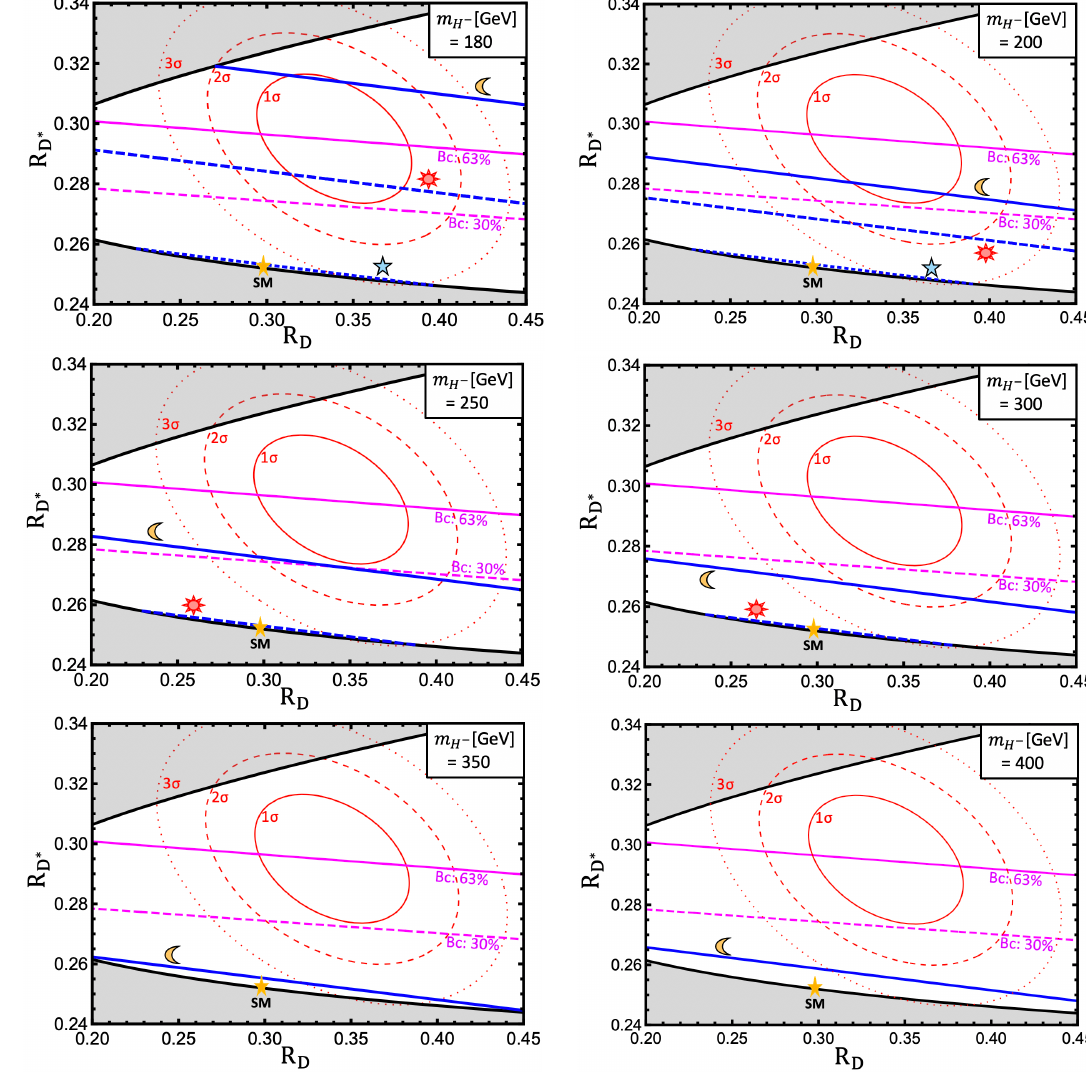
Figure 5 . Sensitivity of the bτν channel shown in the R plane, for fixed charged Higgs masses D ( ∗ ) as shown in the upper right corner. The blue lines show the predictions of the coupling combinations corresponding to the benchmark points in figure 4 and table 3, and are labeled by the respective moon, sun and star symbols. The area above the line is excluded by the respective bound. The world average of the R data at 1, 2 and 3 σ are shown by the red solid, dashed and dotted contours. D ( ∗ ) The HFLAV2021 SM prediction is indicated by a yellow star, and the horizontal magenta solid (dashed) line corresponds to BR( B c → τν ) = 63 (30)% . The grey shaded region is not accessible within our